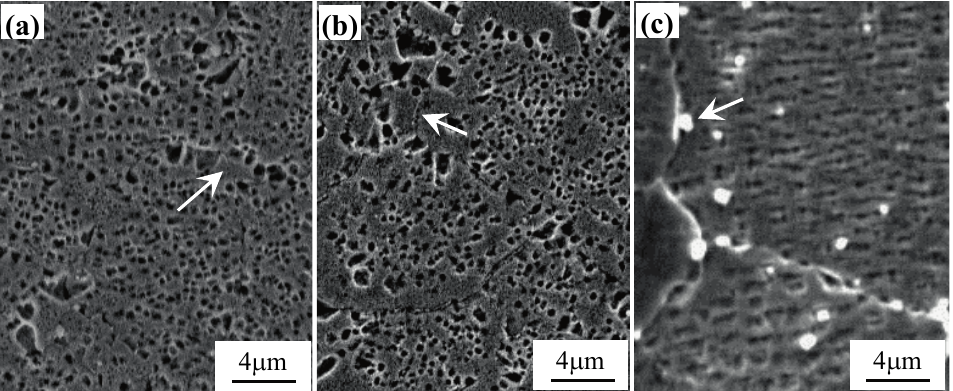
Figure 4. After fully heat treated, magnification morphology of HIP treated alloy at different temperatures. (a) After the 1120 ı C HIP alloy was full heat treated, (cid:2) 0 phase free zone still appeared in the coarser (cid:2) 0 precipitates as marked with arrow , (b) after the 1150 ı C HIP alloy was fully heat treated, grain boundary with straight feature appeared around coarser (cid:2) 0 phase as marked with white arrow, (c) after the 1180 ı C alloy was fully heated, there were some white